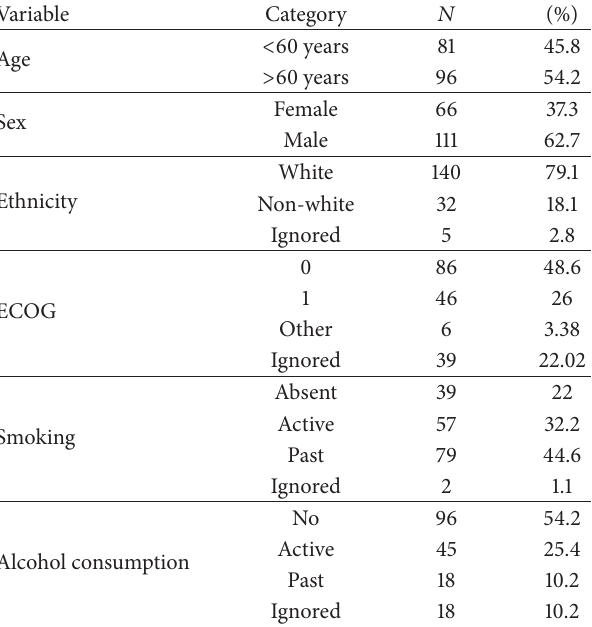
Table 1: Demographic characteristics.